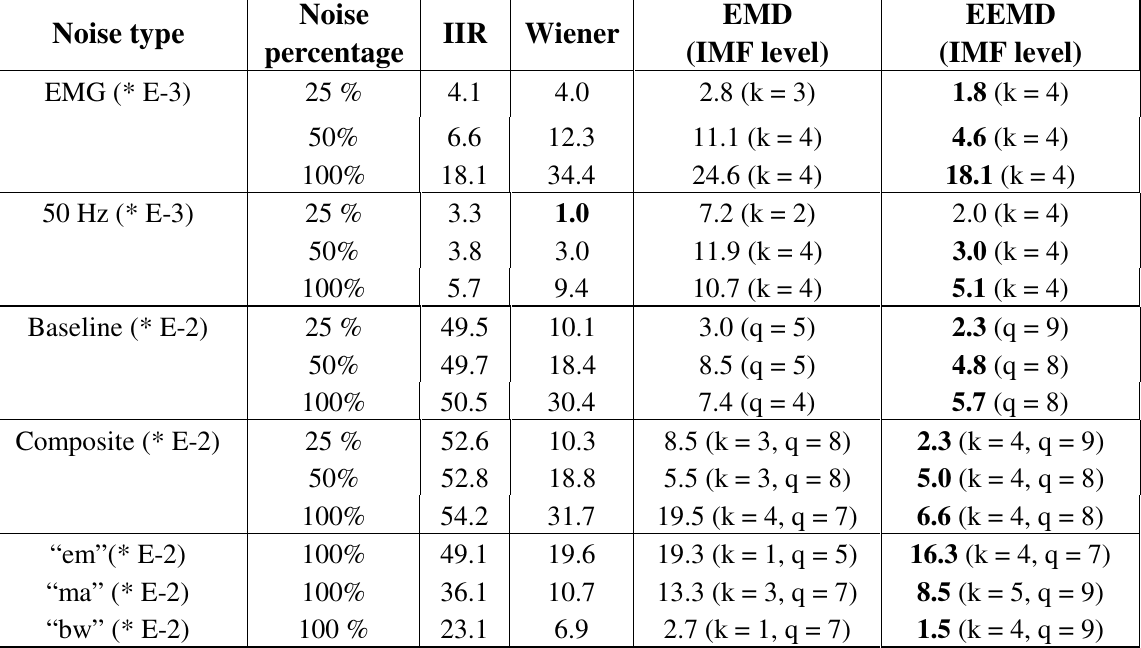
Table 1. MSE result of Ventricular arrhythmia ECG of four filter methods with four noises. Minimum MSE of the same noise are mark